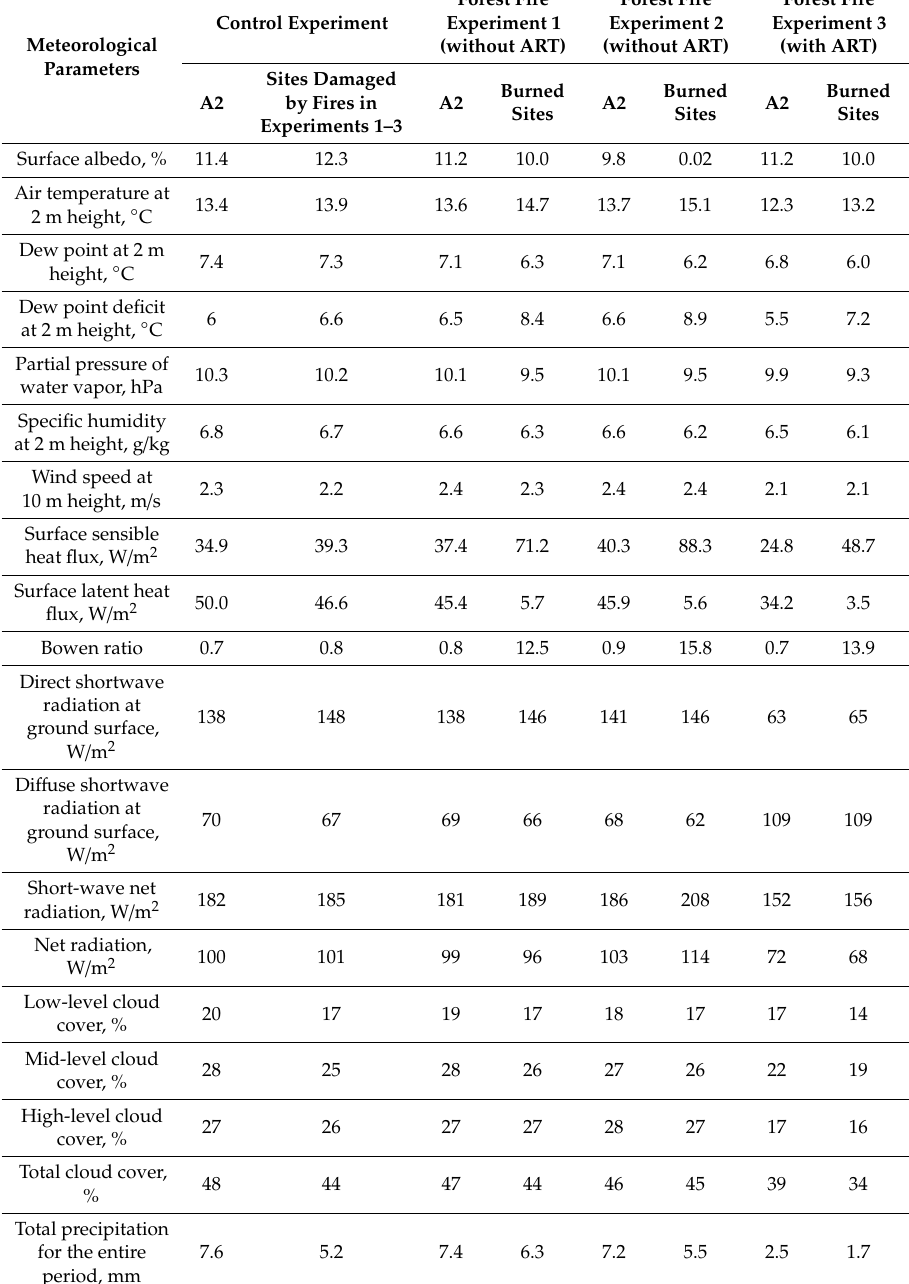
(Table 1; Table 2). A small increase in wind speed (0.1–0.3 m s burned areas in the forest fire experiments 1 and 2. Table 2. Mean values of meteorological parameters for the entire Area 2 (A2) and burnt sites within the Area 2 (Figure 1) from 1 to 14 August 2019 derived from various forest fire